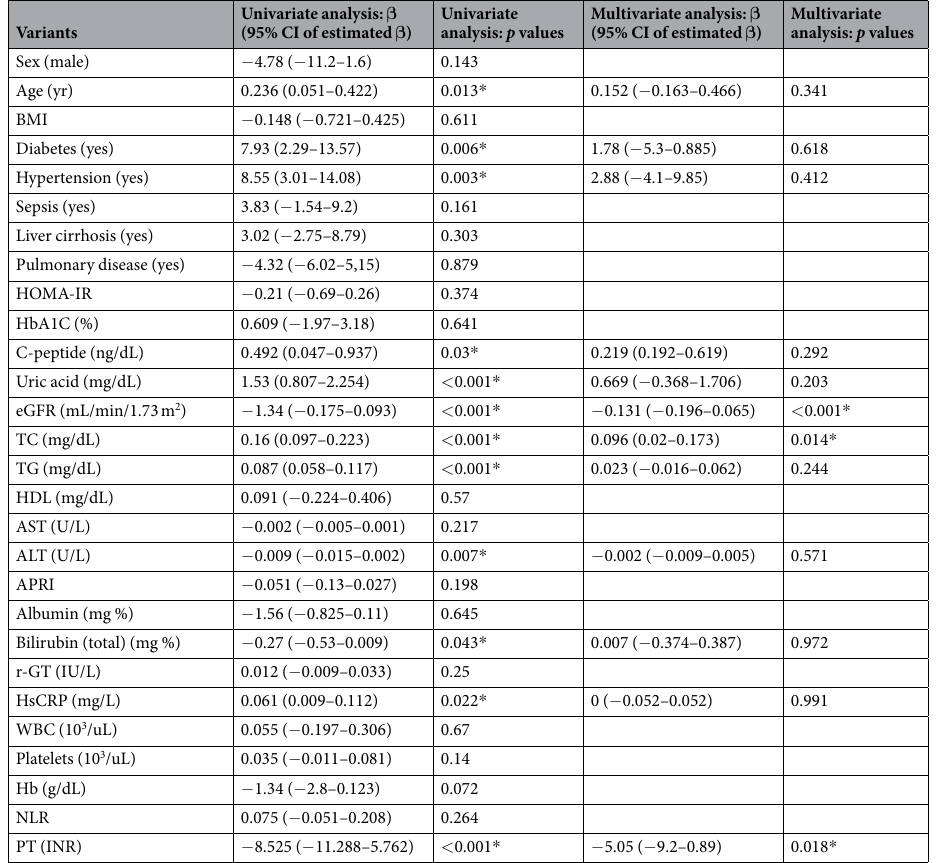
Table 2. Univariate and multivariate analyses of baseline RBP4 levels. RBP4: retinol-binding protein-4; BMI: body mass index; MELD: model for end-stage liver disease; APACHE: acute physiology and chronic health evaluation; ICU: intensive care unit; HOMA-IR: homeostatic model assessment for insulin resistance; TC: total cholesterol; TG: triglyceride; HDL-C: high-density lipoprotein cholesterol; AST: aspartate aminotransferase; ALT: alanine aminotransferase; APRI: aspartate aminotransferase-to-platelet ratio index; r-GT: r-glutamyltransferase; HsCRP: high-sensitivity C-reactive protein; WBC: white blood cell count; NLR: neutrophil-to-lymphocyte ratio; PT: prothrombin time; INR: international normalized